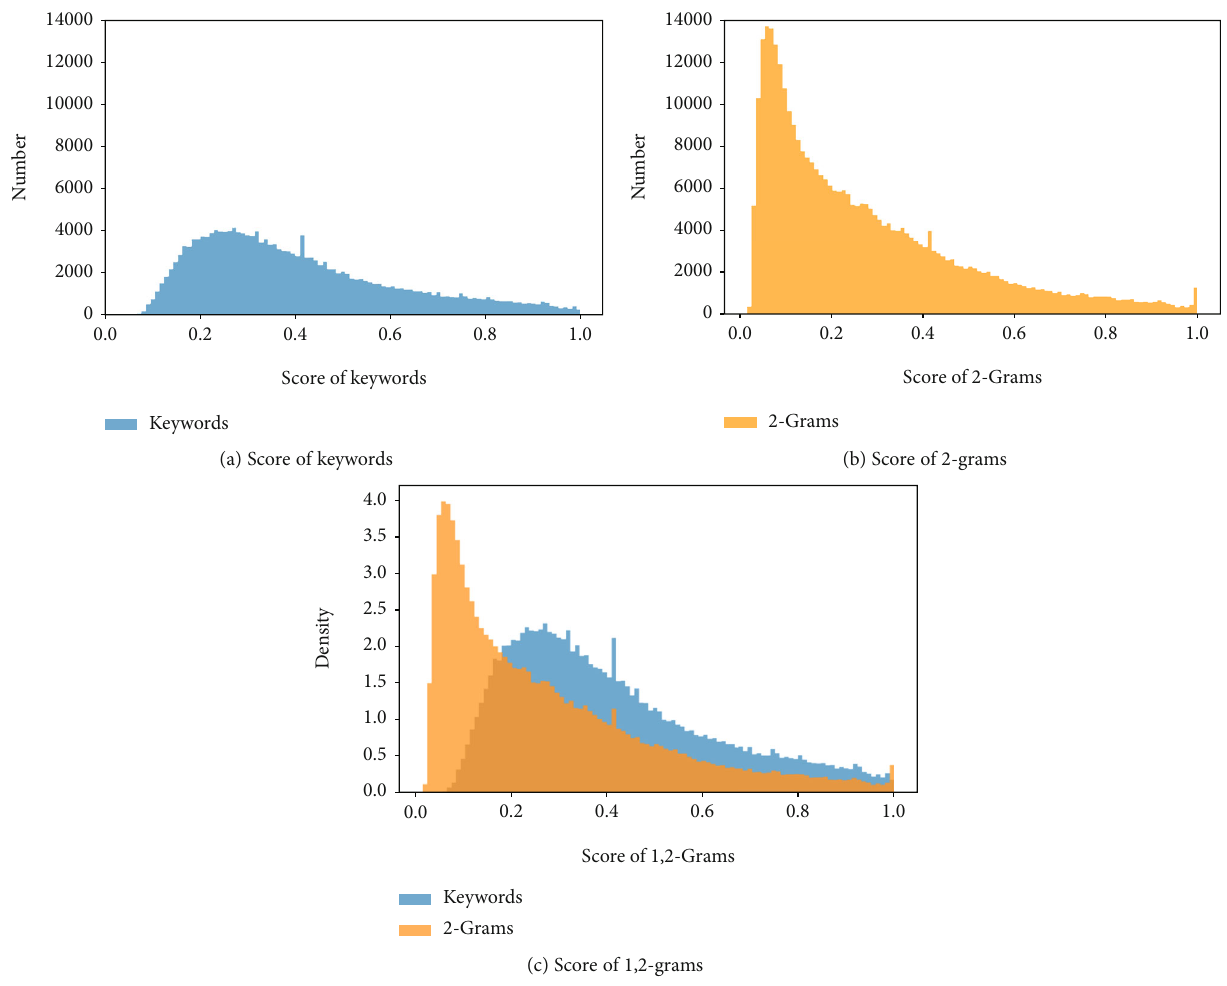
Figure 4: Score density interval histogram distribution of the model ANN with keywords and